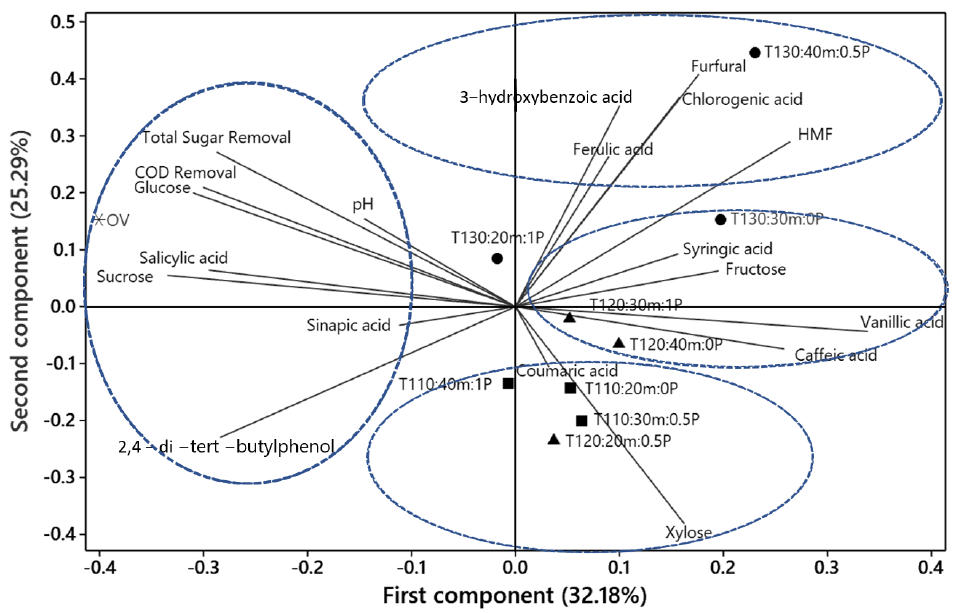
Figure 5. Principal component analysis of furans and phenols present in the samples at the end of the treatments.